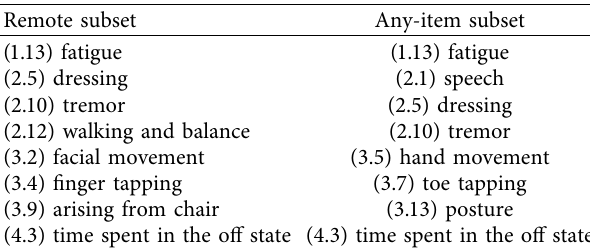
Table 1: Items contained within the subsets that rank highest, by explained variance score on the training dataset, while adhering (“remote”) or not adhering (“any-item”) to the remote assessment constraints defined in Section 2.3. These subsets share four of the same items, and both correspond to the same core aspects of Parkinson’s disease; movement of upper limbs (3.4 or 3.5) and lower limbs (3.9 or 3.7), tremor (2.10), axial (2.12 or 3.13), speech/ facial muscles (3.2 or 2.1), activities of daily living (2.5), fatigue (1.13), and time in Off